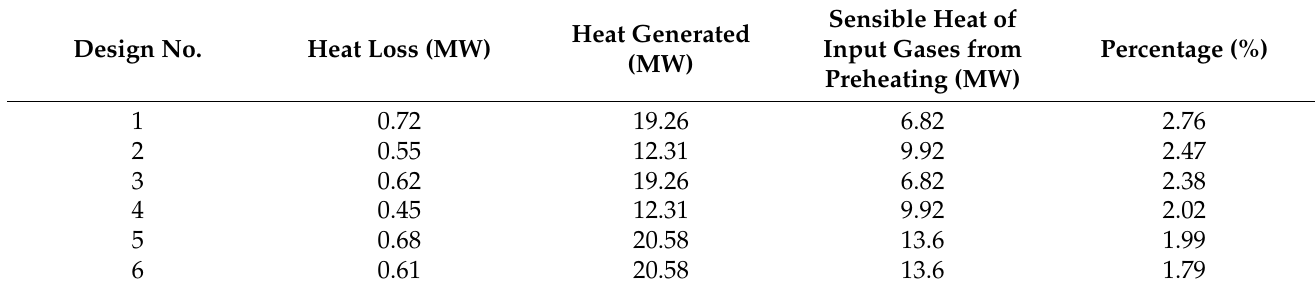
Table 8. Heat loss and heat generated from partial combustion.